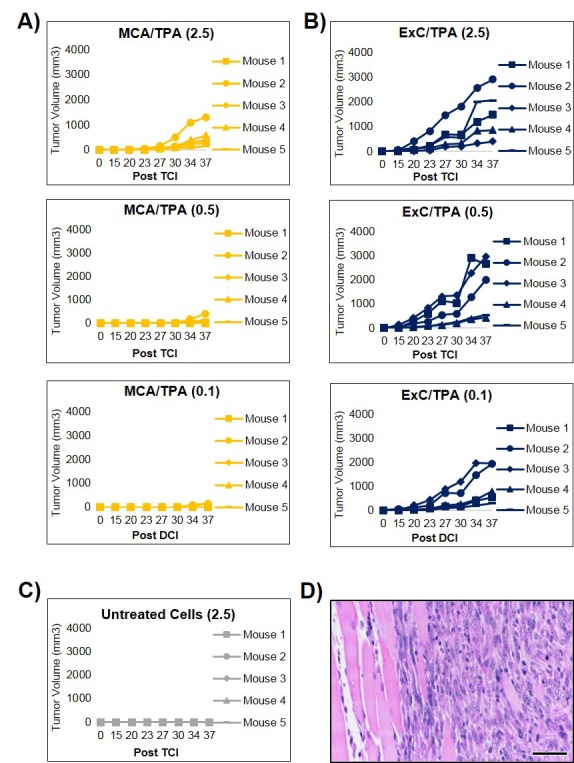
Additional in vivo studies of transformed cells.(A–B) MCA/TPA and Capan-2 exosome (ExC)/TPA transformed cells were each subcutaneously injected into NSG (NOD scid gamma) mice at three concentrations, 2.5 × 106 (2.5), 0.5 × 106 (0.5), and 0.1 × 106 (0.1) cells, to determine sufficient cell density for tumor formation (n = 5 mice for each concentration). Tumor growth was tracked by measuring tumor volume 2x/week for 37 days post injection (Post TCI). (C) Additional replicates of control mice injected with untreated NIH/3T3 cells at a concentration of 2.5 × 106 cells. (D) Histological analysis of one representative tumor formed in mice, confirming that the tumors are fibrosarcomas, scale bar = 50 μm in size.